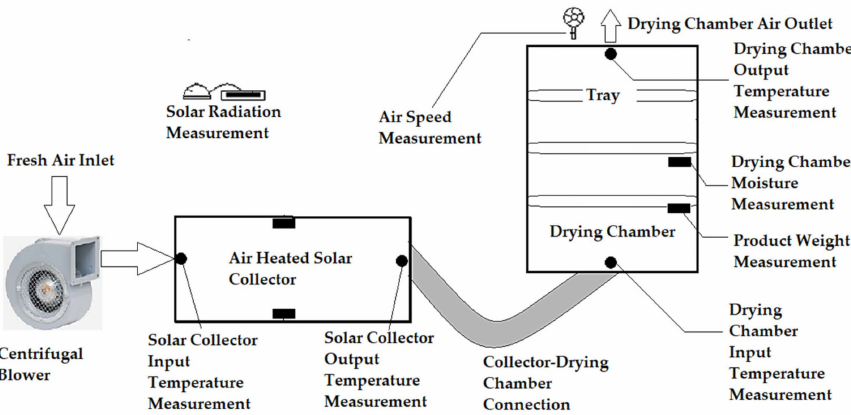
Figure 1. Flowchart of drying process and measurement points.